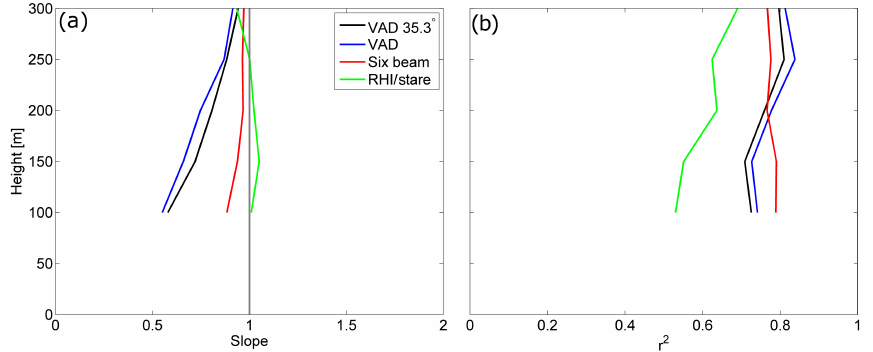
Figure 6. The slope (a) and r 2 (b) of the best fit line on a logarithmic scale (similar to those in Fig. 5) relating TKE measurements from the sonic anemometer and lidar for each measurement height.